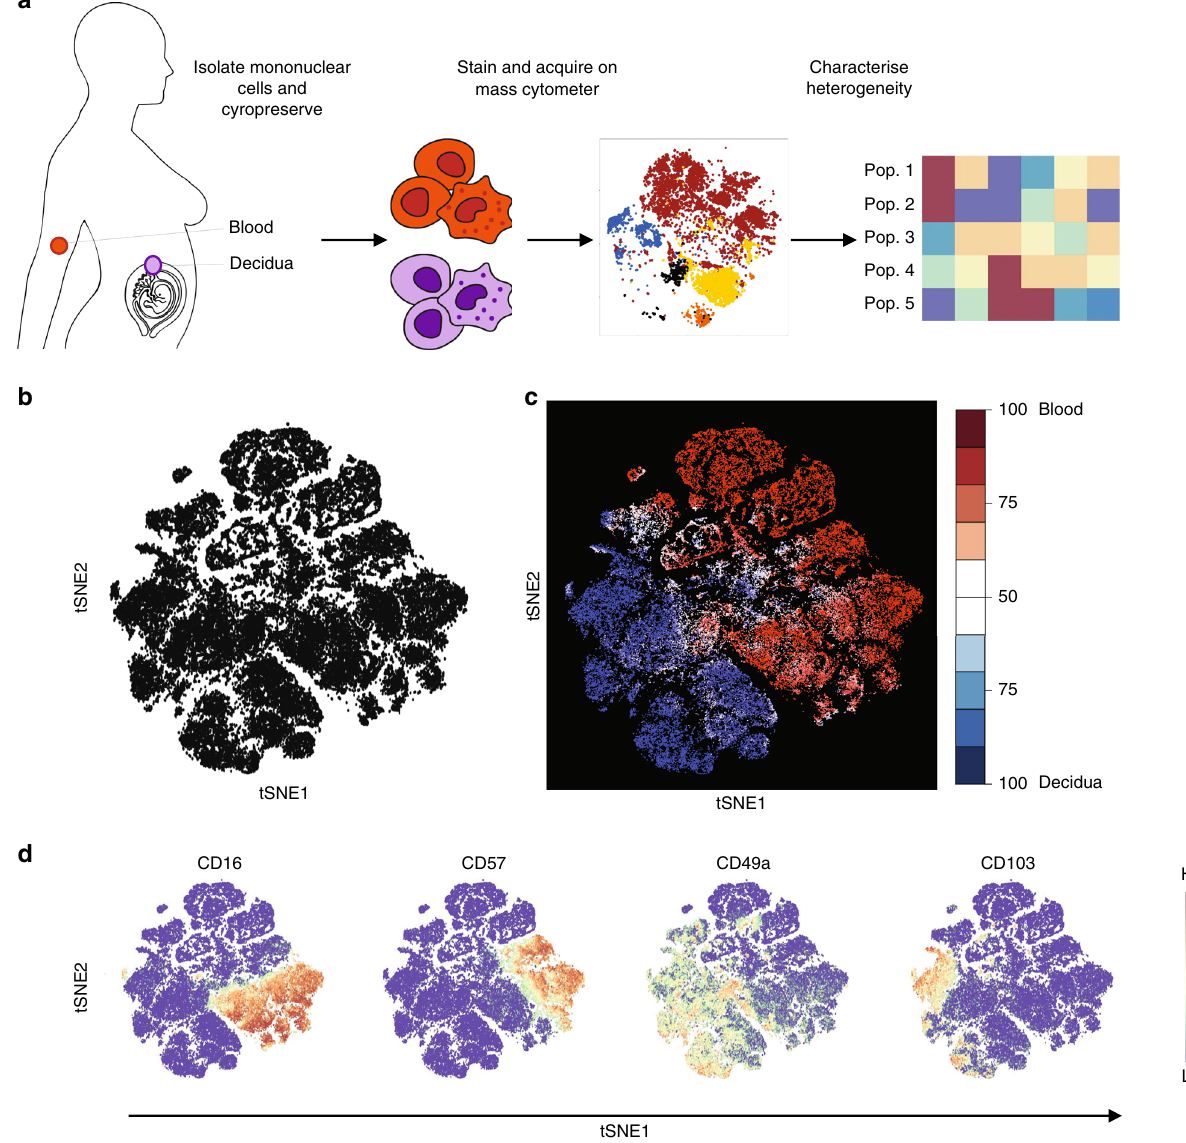
Fig. 1 Decidual ILC subsets identi fi ed by mass cytometry. a Work fl ow summary for the analysis of cryopreserved matched blood and decidual samples by mass cytometry. b t-Distributed Stochastic neighbour embedding (tSNE) landscape of matched CD45 + Lineage negative (Lin − ) (CD3, CD19, CD14, HLA- DR) decidual and peripheral blood mononuclear cells ( n = 6). The algorithm incorporated markers indicated in fi nal column of Supplementary Table 1